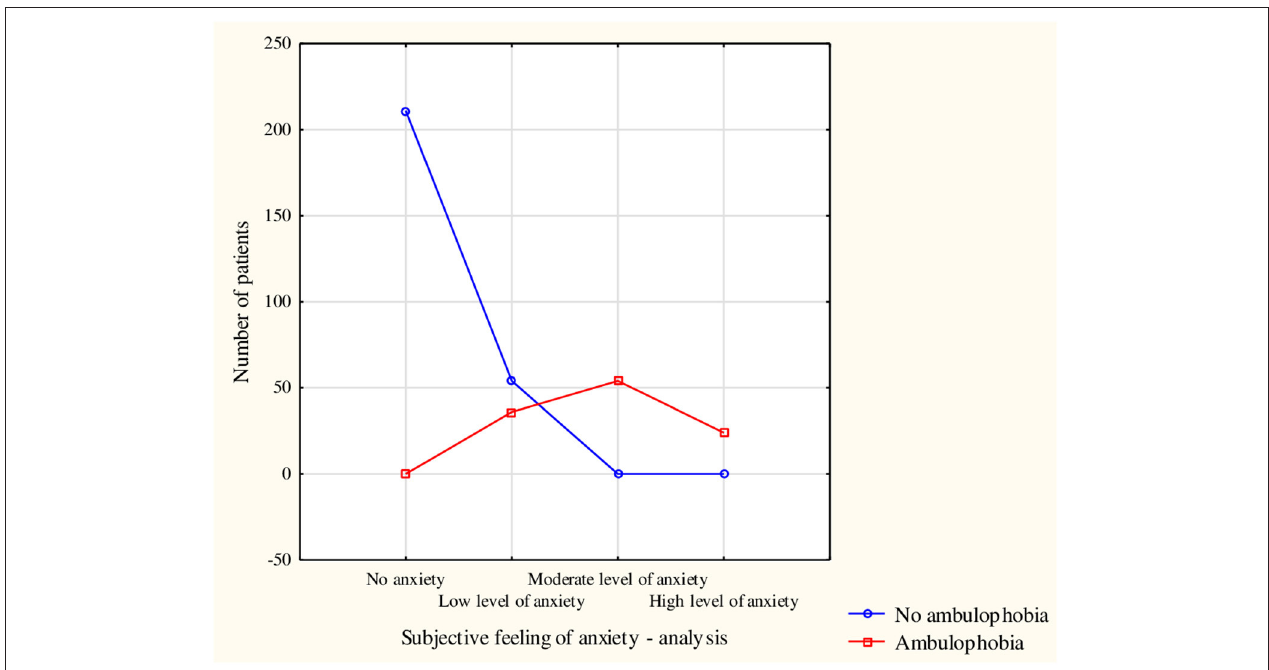
FIGURE 2 | Occurrence of ambulophobia among respondents with a breakdown of subjective experience of fear of falling.